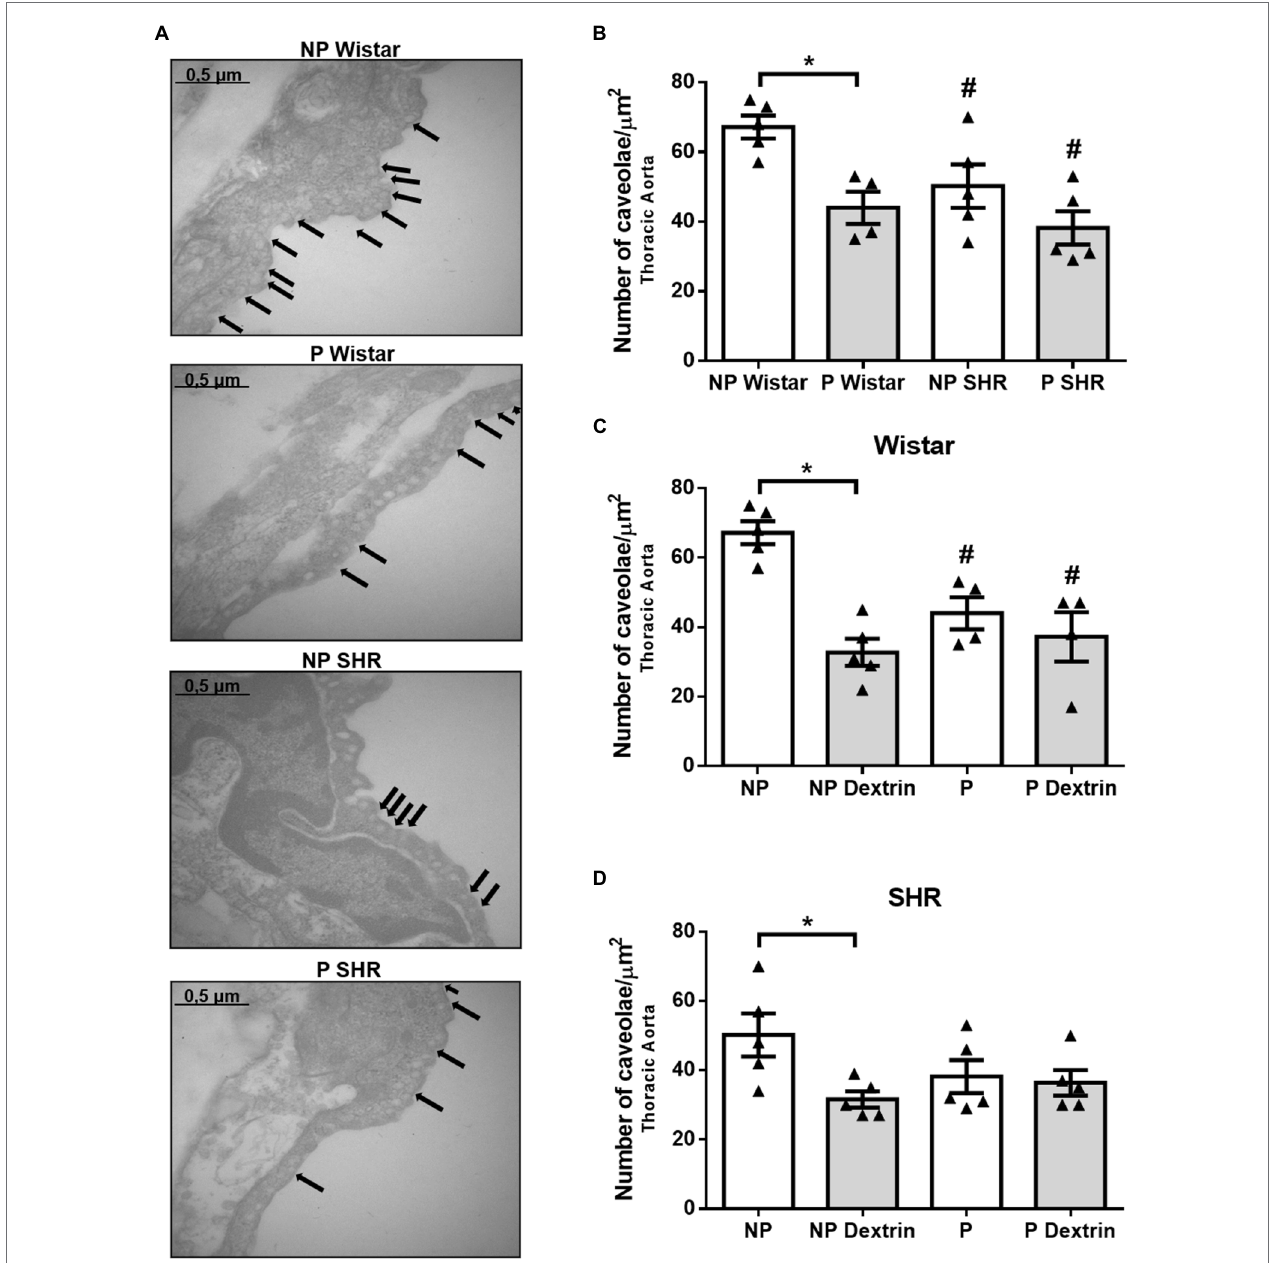
FIGURE 3 | Representative photomicrographs (50,000× magnification, in (A) and quantification of the number of endothelial caveolae/ μ m 2 in aorta of non-pregnant (NP) and pregnant (P) Wistar and spontaneously hypertensive (SHR) rats (B) in the presence of vehicle or dextrin (10 mmol/L, C,D ). The bars represent the mean ± SEM of the results obtained in the aorta ( n = 4–5) from the different groups. * p < 0.05 P Wistar rats or P dextrin versus NP groups; # NP SHR or P SHR versus NP Wistar